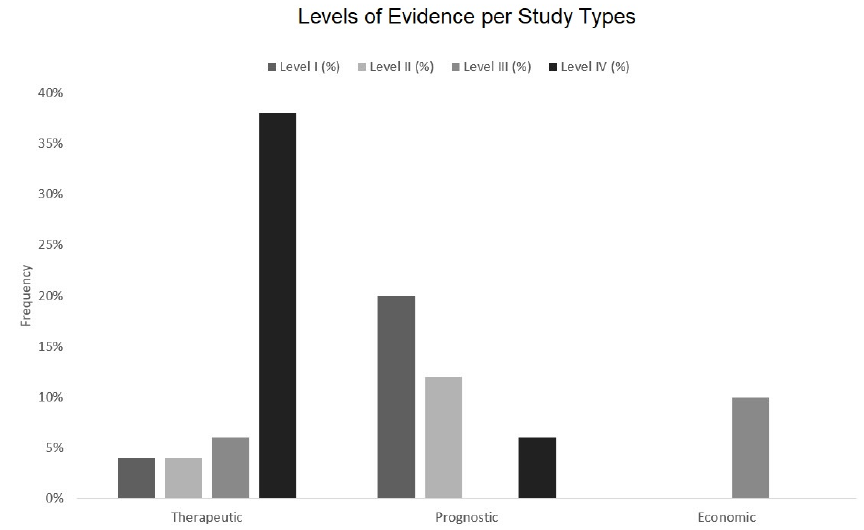
Figure 7. Level of evidence in the categories of therapeutic, prognostic, and economic studies.